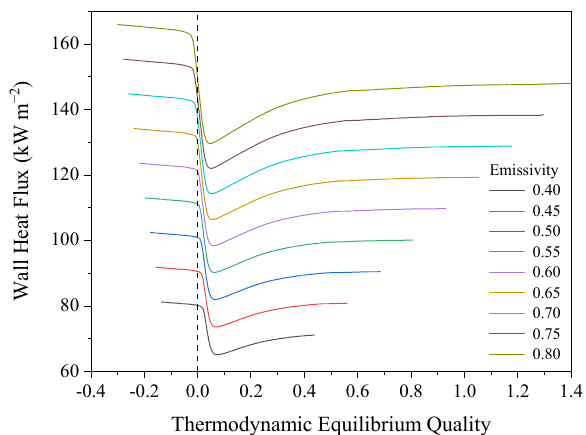
Figure 18. Wall heat flux vs. thermodynamic equilibrium quality under wall emissivity from 0.40 to 0.80.